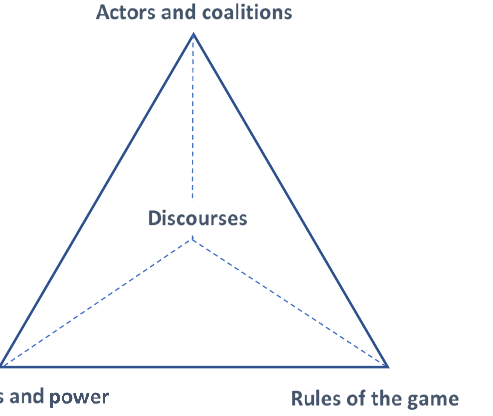
Figure 1. Schematic representation of a single policy arrangement. Adapted from Liefferink in Reference [29].